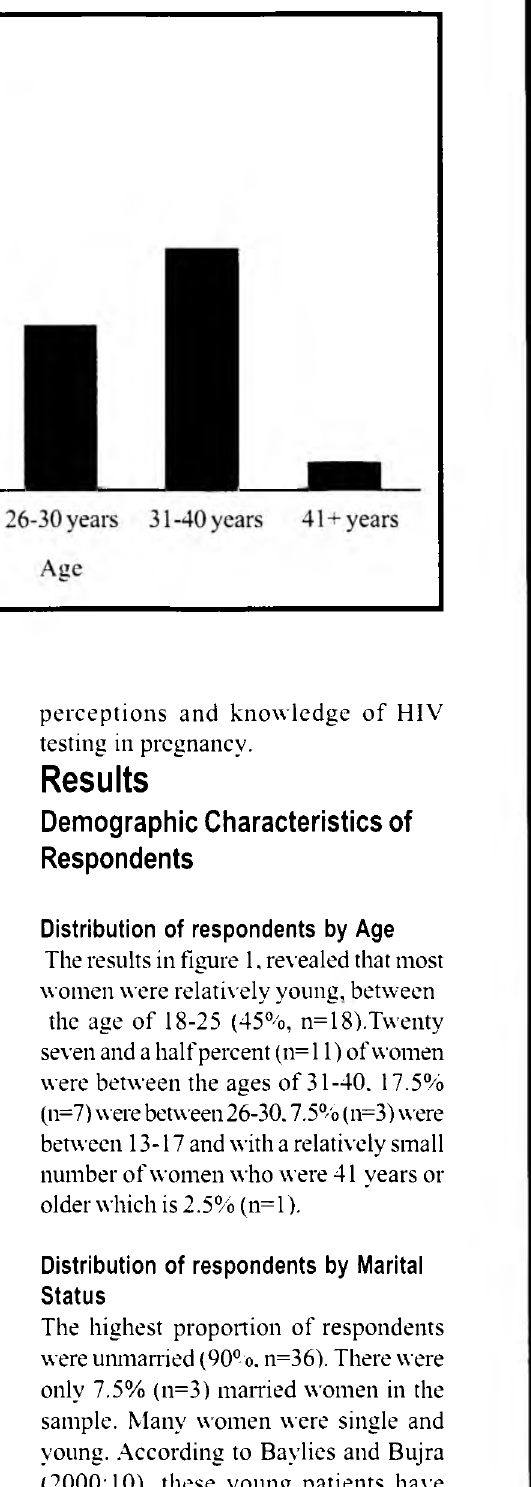
Figure 1. Age Distribution